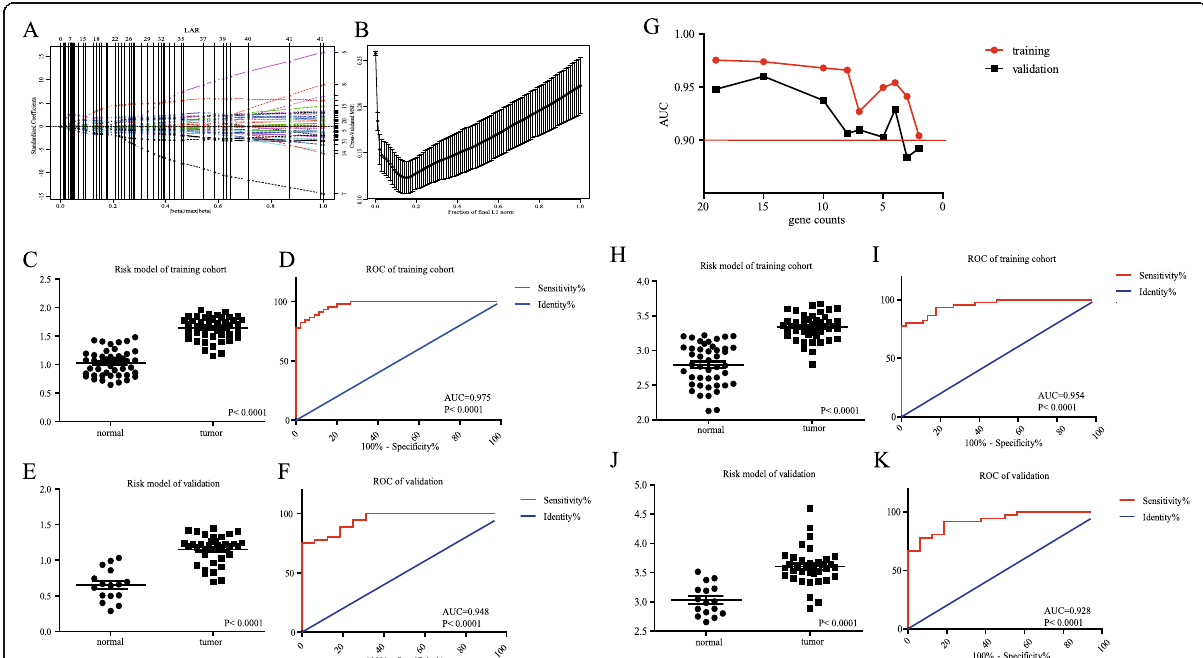
Fig. 5 Construction of risk model for diagnosis of pancreatic carcinoma and ROC curve. a The solution paths of lasso regression model. The numbers on the right represented which variable each path corresponds to. Horizontal axis represented |beta|/max|beta| and vertical lines showed the event times for easy comparison between various solution paths. b The relationship between cross-validated mean square error (CV MSE) and model size. Horizontal axis represented fraction of final L1 norm, which referred to the ratio of the L1 norm of the coeffcient vector relative to the norm at the full least squares solution for the model with the maximum steps used. c The distribution of risk score of normal and tumor group of training set-GSE28735. d ROC curve of risk score for differentiating tumor from normal of training set. e The distribution of risk score of normal and tumor group of validation set-GSE16515. f ROC curve of risk model for differentiating tumor from normal of validation set. g The relation between gene counts that involve in diagnostic risk model and AUC of training cohort and validation cohort. h The distribution of risk score of normal and tumor group of training set-GSE28735 for simplified diagnostic risk model. i ROC curve of risk score for simplified diagnostic risk model of training set. j The distribution of risk score of normal and tumor group of validation set-GSE16515 for simplified diagnostic risk model. k ROC curve of risk score for simplified diagnostic risk model of validation set. AUC, area under the curve; ROC curve, Receiver operating characteristic